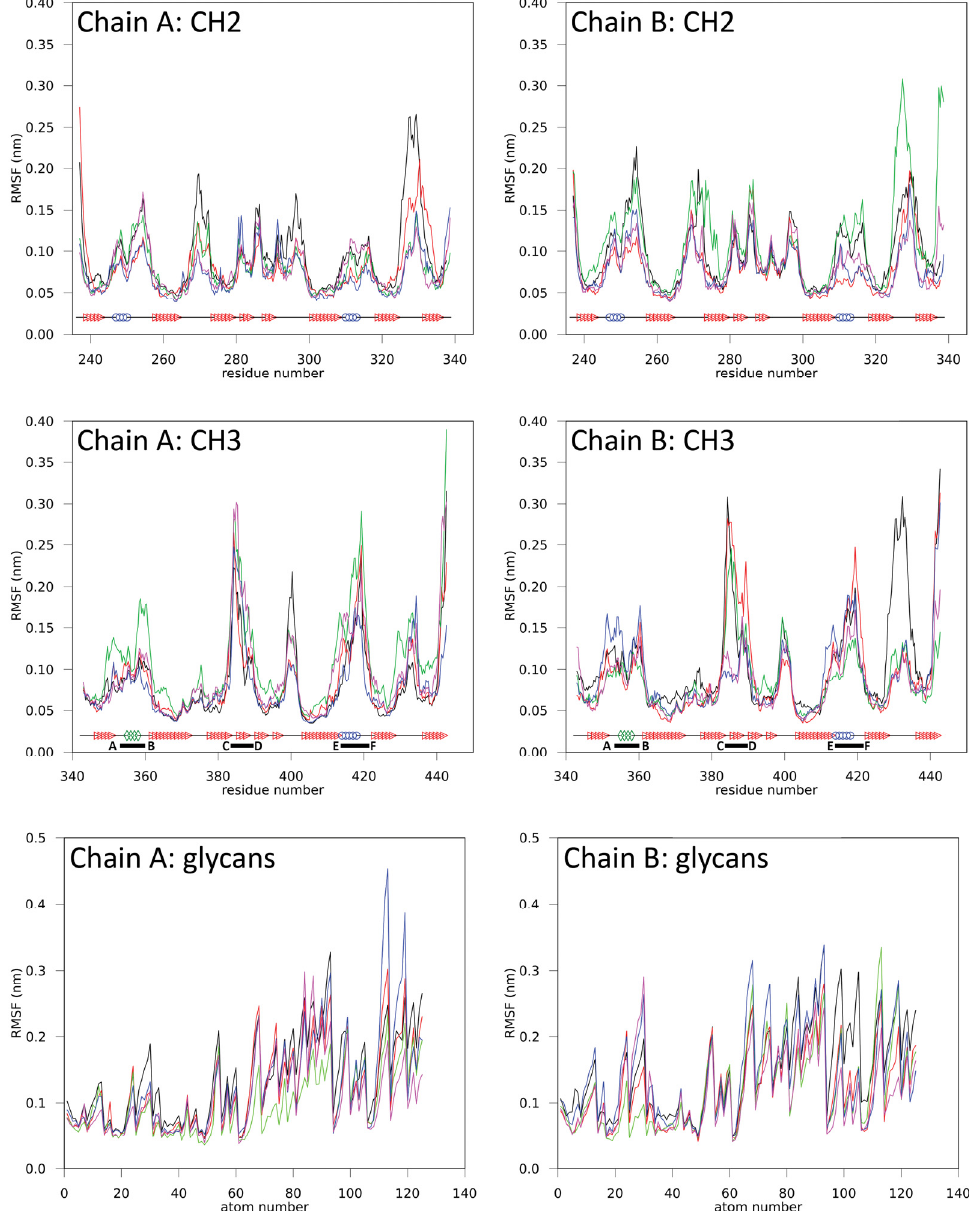
Figure 2. Atom-positional root-mean-square fluctuations (RMSF) for backbone atoms in various domains and glycans in simulations B4 ( black ), B7 ( red ), H4 ( green ), H7 ( blue ) and Q347E ( magenta ). CH2 and CH3 domain secondary structures are shown: helices ( blue circle ), 3/10 helices ( green diamonds ), β -sheets ( red triangle ) and coils ( black line ). C -terminal loop regions are indicated by corresponding letters and a solid black bar, which specifies the name and range of the